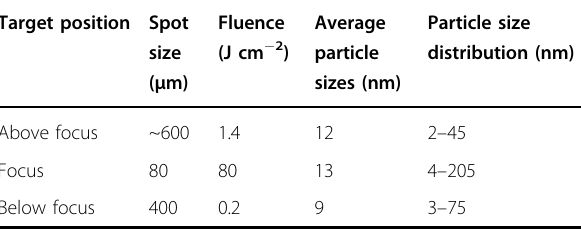
Table 1 Effects of laser and NPs parameters during the ablation of the Ti target in a water medium in a fi xed focal length of 5 cm at various target positions 31 Target position Spot